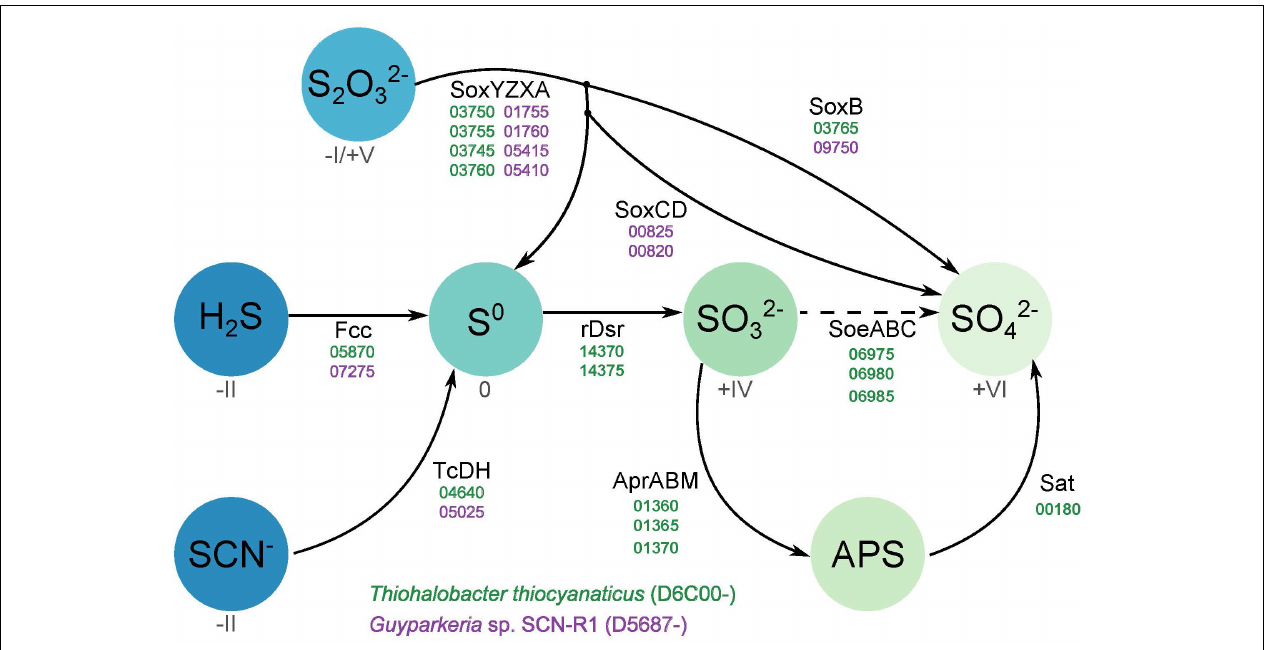
FIGURE 2 | Overview of the different sulfur oxidation genes present in Thiohalobacter thiocyanaticus and Guyparkeria sp. SCN-R1. Dash arrow – hypothetical